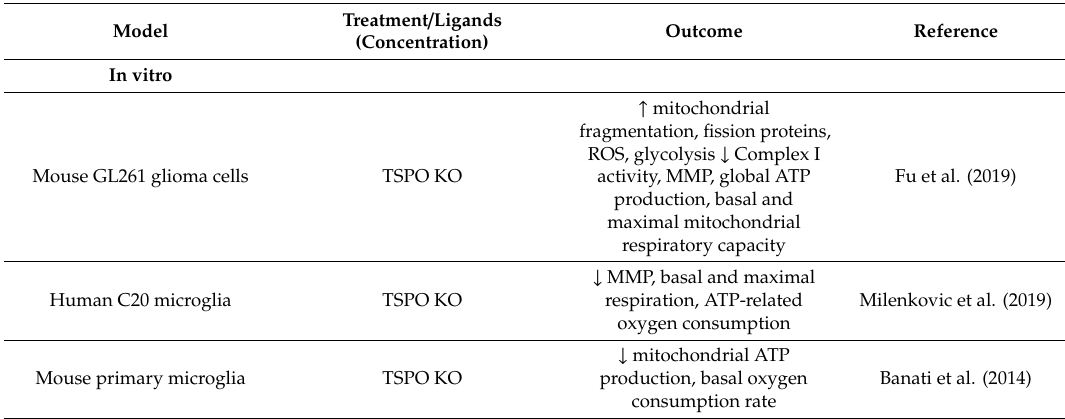
Figure 1. Overview of the translocator protein (TSPO) in the inflammatory responses of microglia and its interaction with mitochondrial processes. Under stress conditions, TSPO is upregulated in activated, pro-inflammatory (M1) microglia. Located on the outer mitochondrial membrane, TSPO interacts with reactive oxygen species (ROS), a key part of the microglial inflammatory response. TSPO also interacts with inflammatory transcriptional pathways including MAPK and the NLRP3 inflammasome, resulting in the release of cytokines. These processes can be modulated by TSPO ligands, and by genetic deletion of TSPO, indicating a key role for TSPO in these processes. Summary of in vitro and in vivo experimental data describing the role of TSPO in mitochondrial